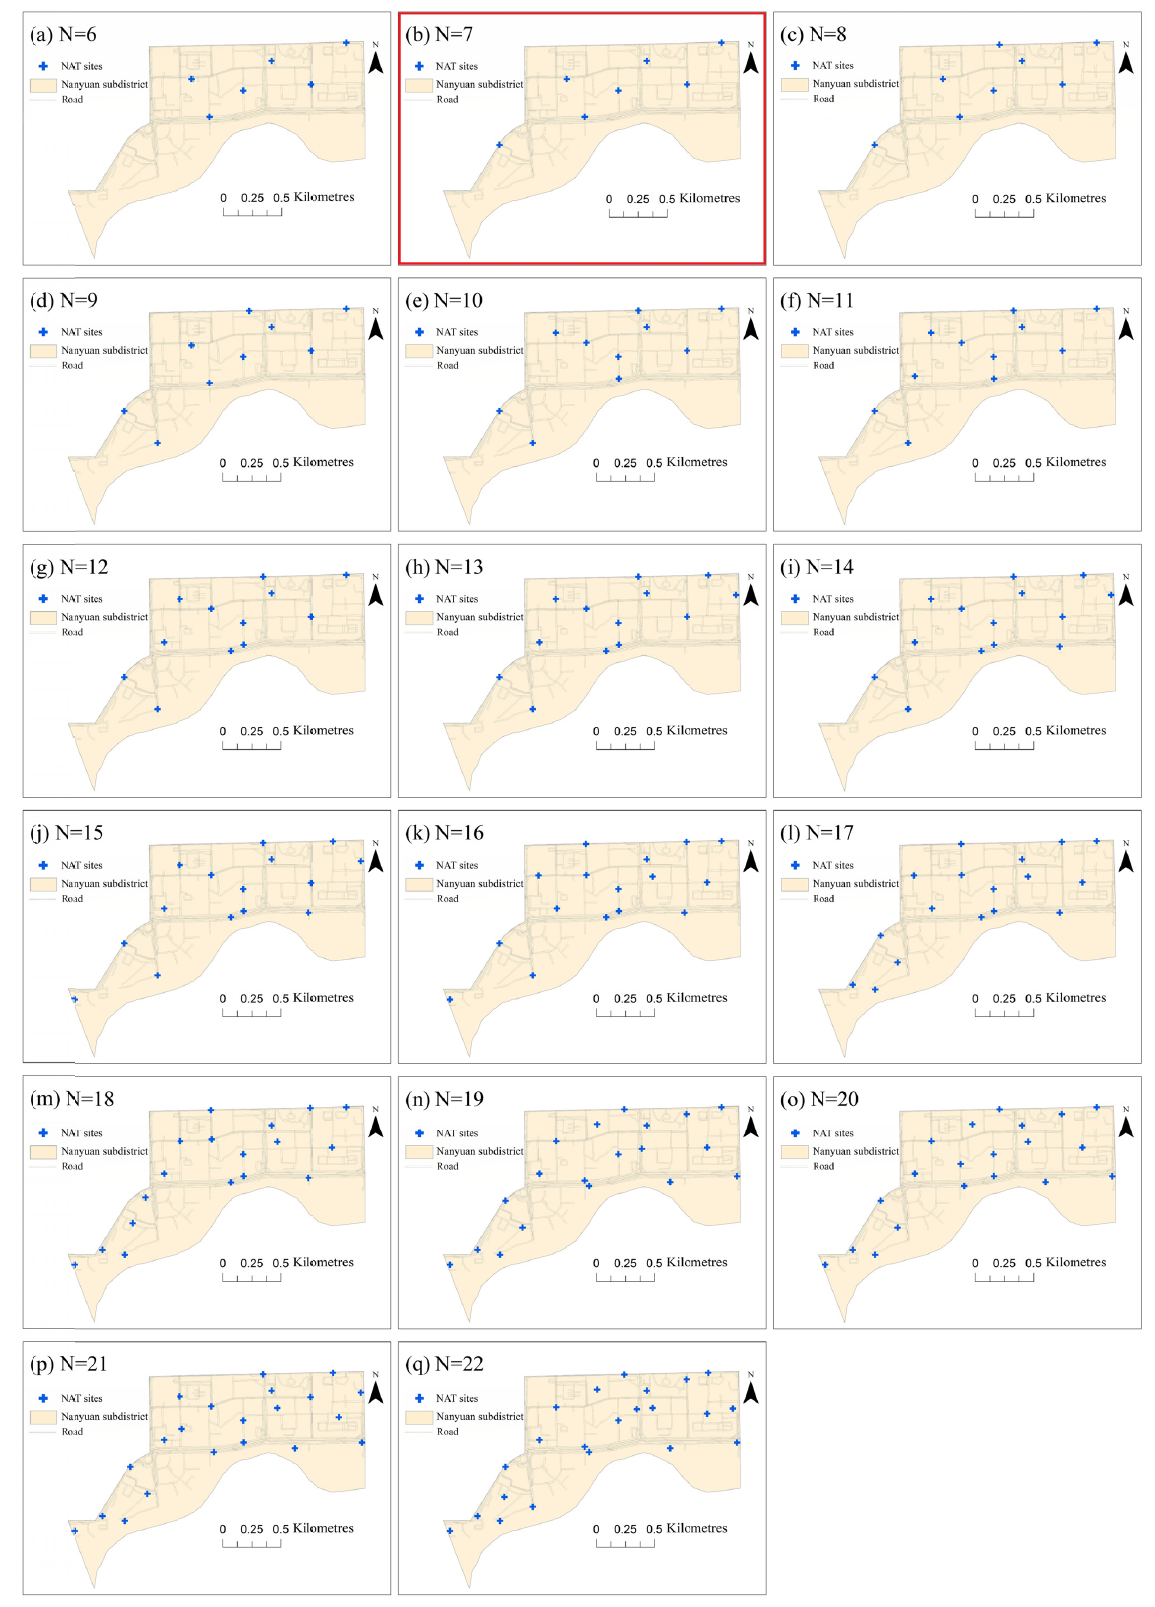
Figure 6. Alternative siting plans of NAT sites under different values of N